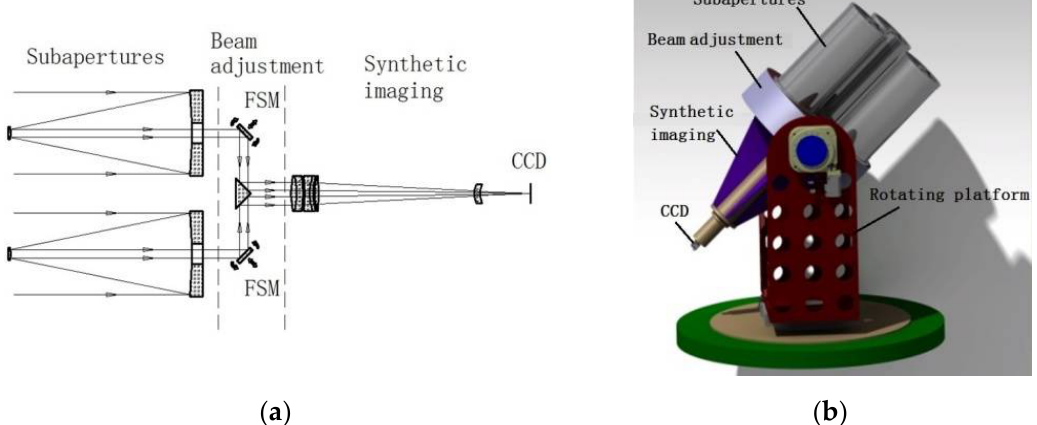
Figure 1. Golay3 system: ( a ) side view of the light path structure; ( b ) three-dimensional model.